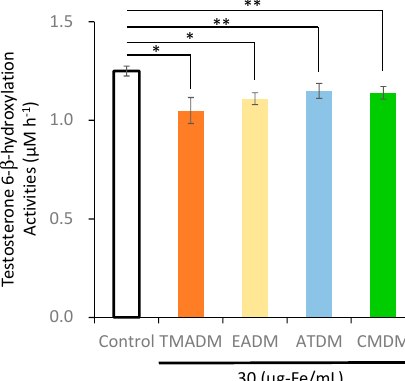
Figure 4. Drug-metabolizing activities of hepatocyte–endothelial cell heterospheroids labeled with polysaccharide magnetic iron oxide nanoparticles (TMADM, EADM, ATDM, and CMDM). The heterospheroids were incubated for 2 d at 37 °C. After 48 h of cell culture, the heterospheroids were then incubated with various nanoparticles (30 μ g-Fe/mL) for 24 h at 37 °C. Testosterone 6- β -hydroxylation was determined by 4 h incubation with 100 μ mol/L testosterone. The data shown represent the means and standard deviation (SD) of three independent experiments. Statistically significant difference was observed in the control group (non-labeled heterospheroids, 0 μ g-Fe/mL) and the labeled groups with various nanoparticles (* p < 0.01, ** p < 0.05).